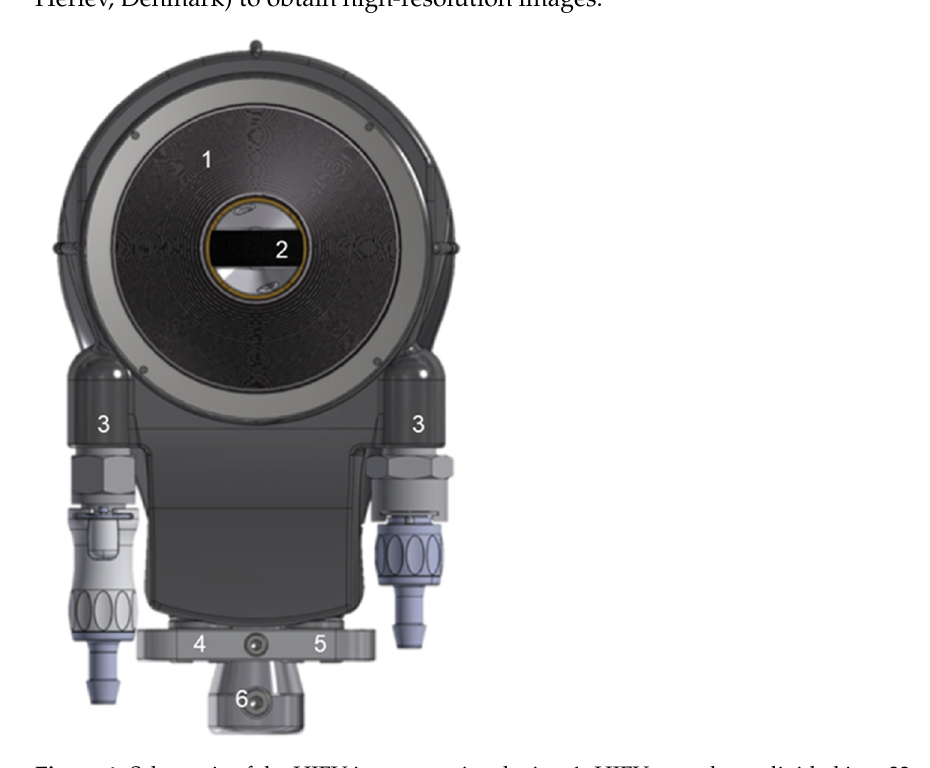
Figure 1. Schematic of the HIFU intraoperative device. 1: HIFU transducer divided into 32 concentric rings. 2: Ultrasound imaging probe. 3: Connectors for the cooling circuit. 4: Connectors for the coaxial cables of the HIFU emitters. 5: Connectors for the cables of the ultrasound imaging probe. 6: Connector for the mechanical arm.